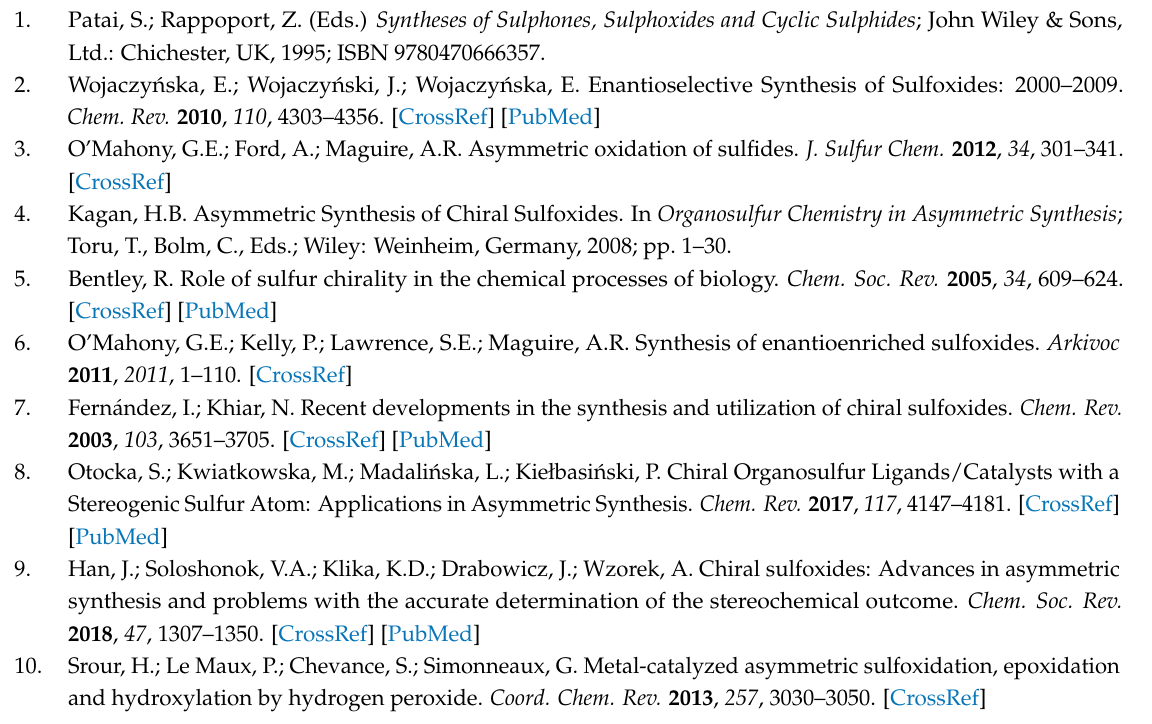
Supplementary Materials: The following are available online, Figures S1–S6: NMR and MS spectra of 1 compounds, Figure S7: calculated IR spectrum of 2c , Figures S7 and S8: determination of the stereoselectivity factor, Figures S10 and S11: optimized structures of transition states and compounds 2 , Figure S12: selected chiral HPLC diagrams of optical active sulfoxides, Table S1: energies of the transition states for the oxido-transfer, and Table S2: Coordinates of the optimized